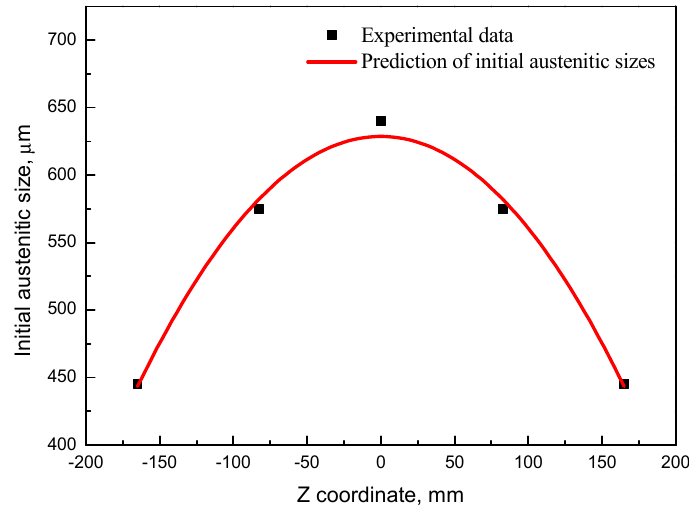
Figure 14. Microstructure comparison of the feature points of slabs with and without the HHR 2 process: before the HHR 2 process, ( a ) surface, ( b ) 1/4 thickness, and ( c ) core; after the HHR 2 process, ( d ) surface, ( e ) 1/4 thickness, and ( f ) core .